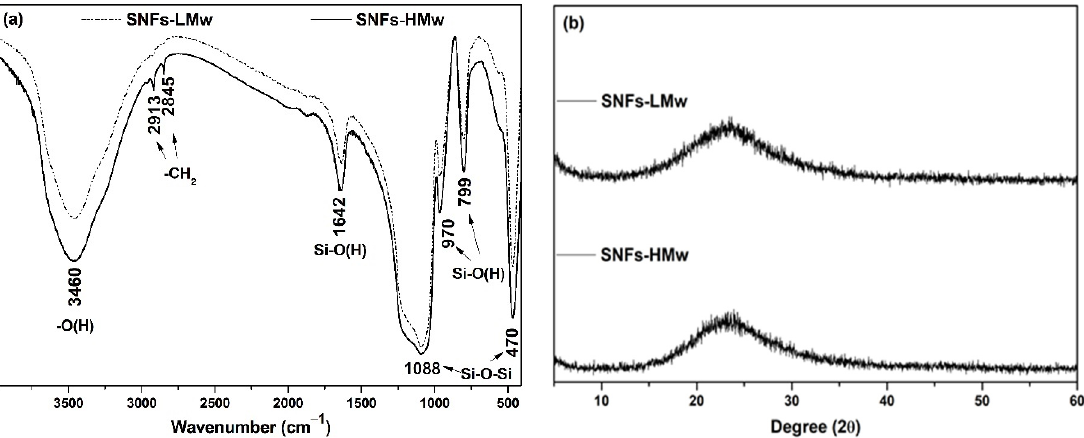
Figure 3. ( a ) FT-IR spectra and ( b ) XRD pattern of SNFs-LMw and SNFs-HMw.